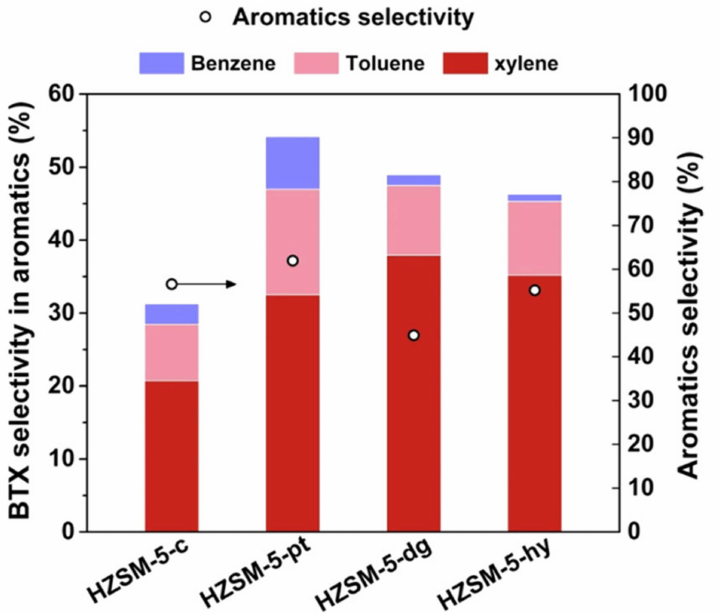
Figure 13. BTX selectivity in aromatics and aromatic selectivity on 6.25Cu-Fe 2 O 3 integrated with different HZSM-5 zeolites. Reaction conditions: 320 ◦ C, 3.0 MPa, GHSV = 1000 mL · g cat − 1 · h − 1 , H 2 /CO 2 /N 2 = 72/24/4, 2 g tandem catalysts. Reprinted with permission from Song et al. [115]. Copyright (2020) American Chemical